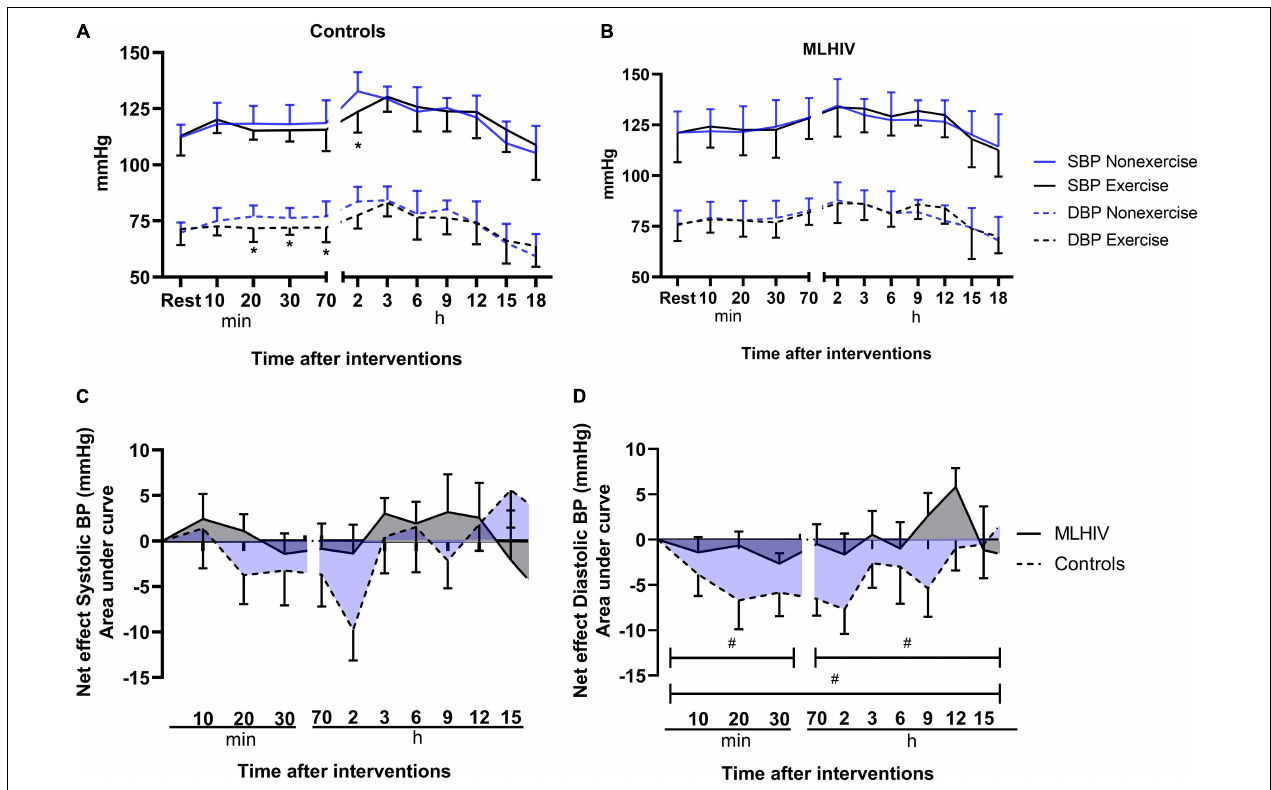
FIGURE 2 | Blood pressure after submaximal exercise or non-exercise sessions in controls (A) and men living with HIV (B) and exercise net effects on systolic (C) and diastolic (D) blood pressure. SBP, systolic blood pressure; DBP, diastolic blood pressure. * p < 0.05 for changes from baseline (exercise vs. non-exercise session) using linear mixed models. # p < 0.05 for differences between areas under the curves of controls vs. MLHIV.